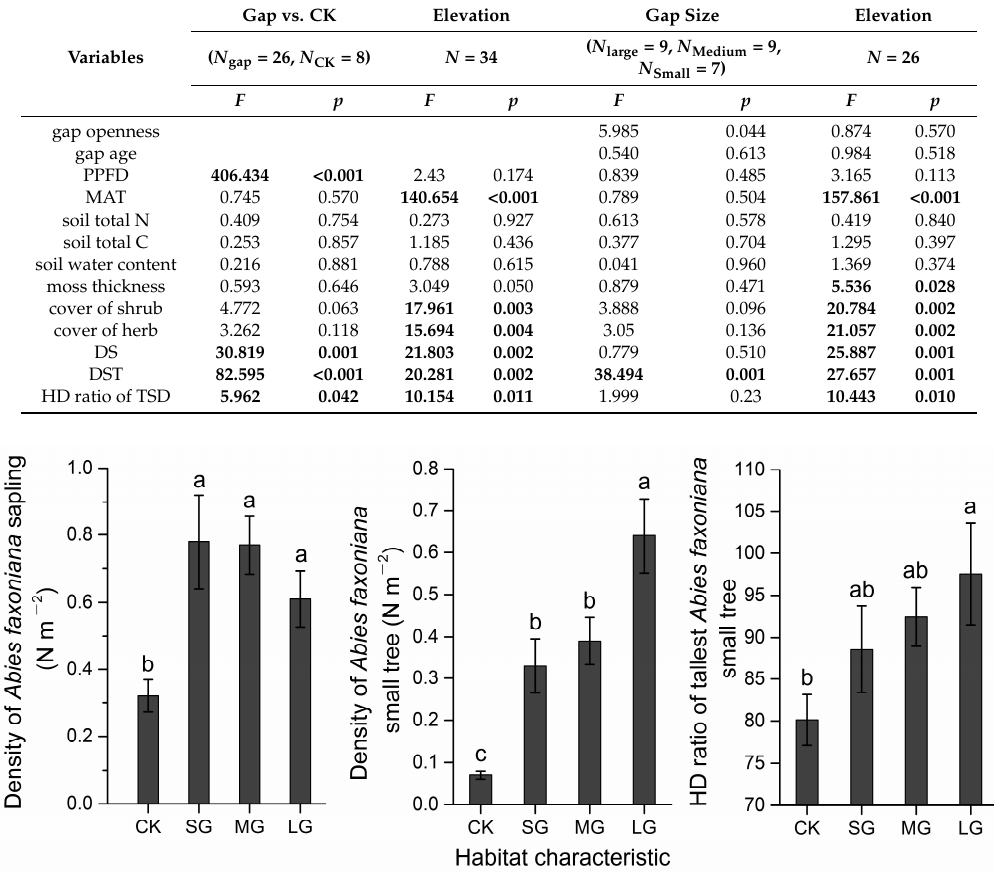
Figure 3. Data of Abies faxoniana regeneration (density of Abies faxoniana saplings, density of Abies faxoniana small trees, and the HD ratio of the tallest Abies faxoniana small trees) in different habitats (forest and different gap size) for the study area in a subalpine coniferous forest. LG, MG, and SG represent a large gap, medium gap, and small gap, respectively. CK represents non-gap plots. Different letters denote significant difference between treatments (Bonferroni-adjusted p -values < 0.01) by Duncan test.